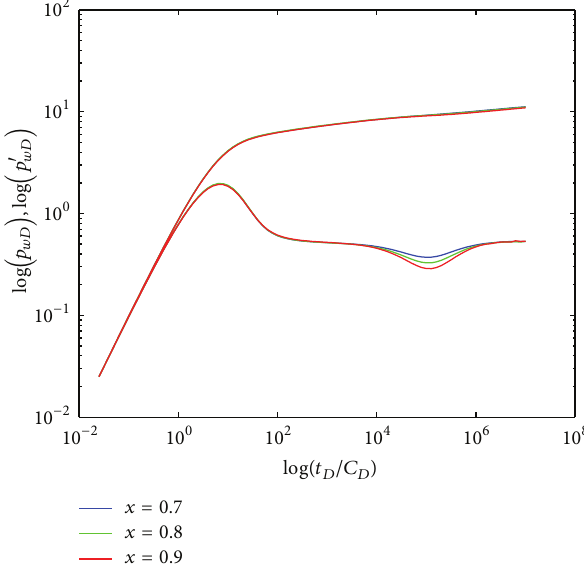
Figure 3: Type curves of well testing in crossflow double-layer reservoir by polymer flooding.